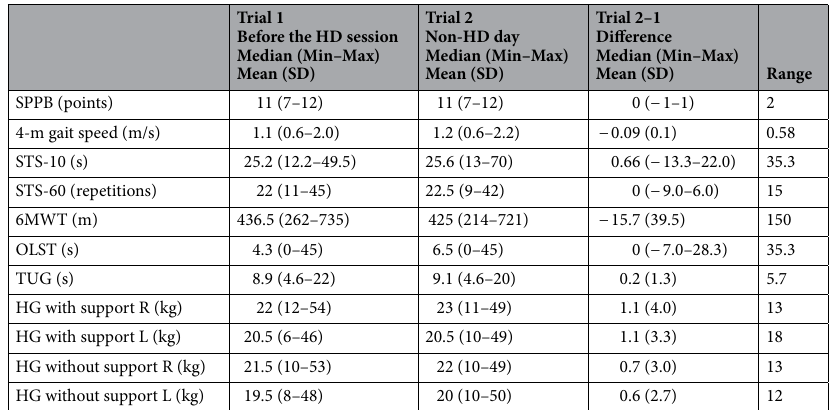
Table 2. Descriptive values (N = 30). n = 30. HD haemodialysis, HG handgrip strength, L left side, OLST one- legged stance test, R right side, SPPB short physical performance battery, STS10 sit-to-stand 10 test, STS60 sit-to-stand 60 test, TUG timed up-and-go test, 6MWT 6-min walking test.